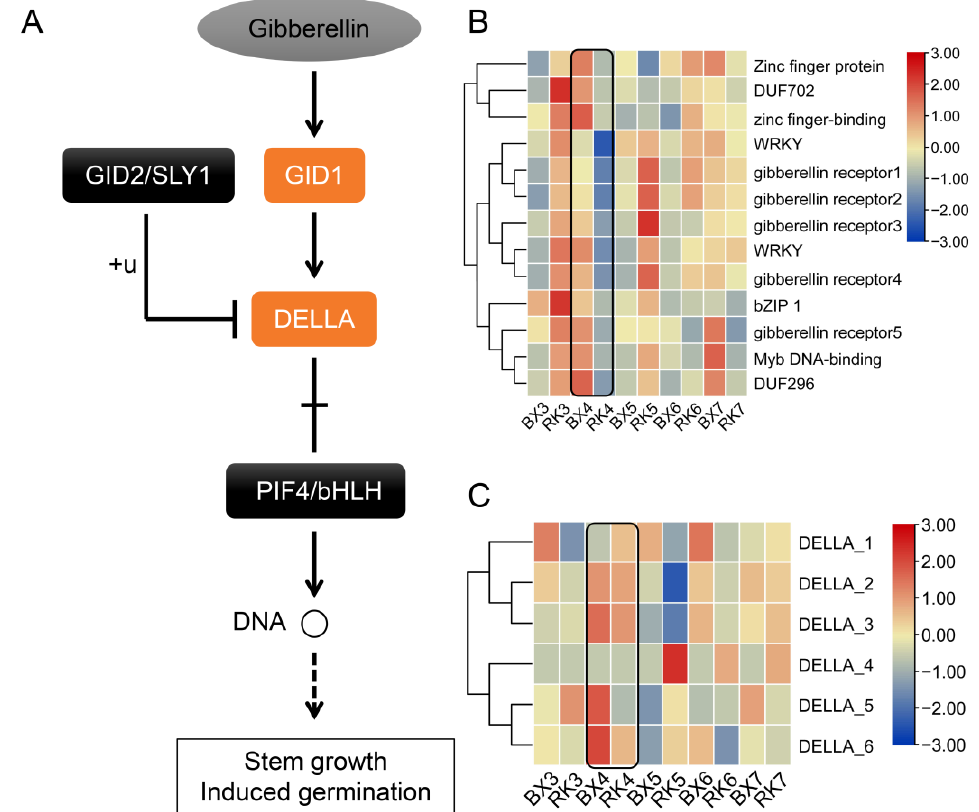
Figure 4. The expressions of DEGs in GA signal transduction pathway at different growth stages. ( A ) GA signal transduction pathway; ( B ) expression heatmap of DEG expressions in gibberellin receptor GID1; ( C ) expression heatmap of DELLA genes. The color scale ranging from blue to red represents the expression levels of genes.